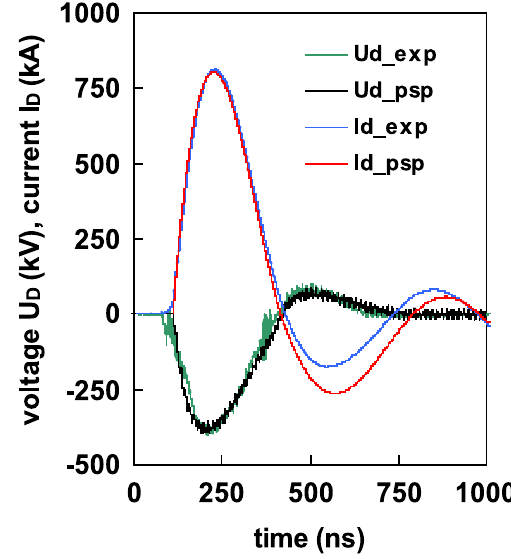
FIG. 12. (Color) Experimental results and PSPICE simulations. The diode voltage U D for clarity of presentation is inverted (negative). The simulations were done for U CH ¼ (cid:3) 90 kV and an emitting cathode area A ¼ 2100 cm 2 . The cathode emitting surface was assumed to be moving towards the anode at a constant velocity V ¼ 2 (cid:4) 10 6 cm = s , simulating the expansion of the cathode